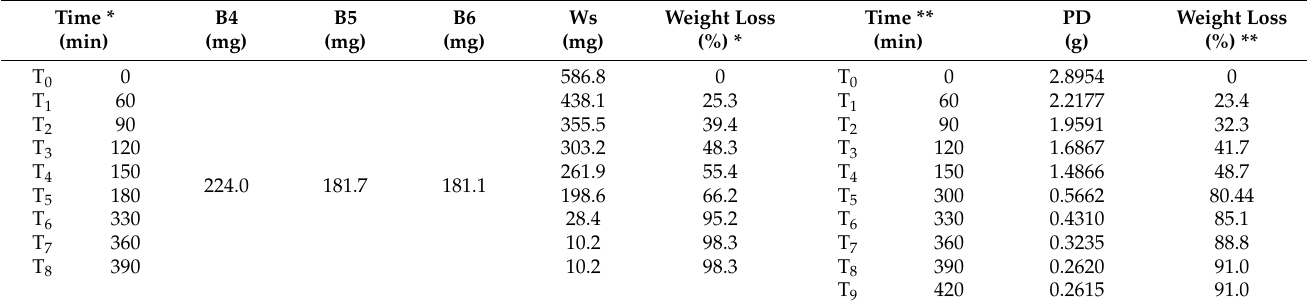
Table 2. Weights of gels in Ws and in the PD determined at times T 0 –T x .